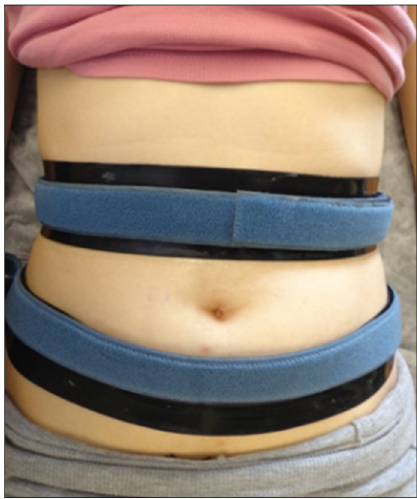
Figure 1. Placement of the transcutaneous electrodes in a band in the abdominal